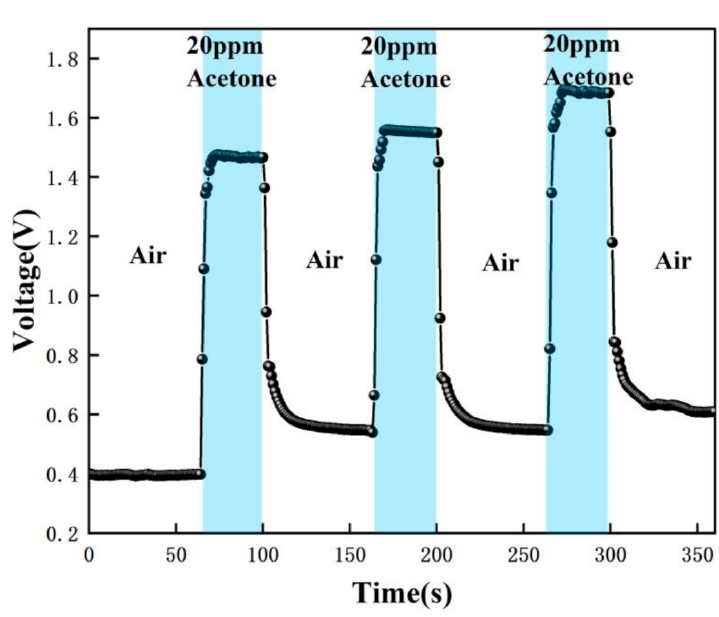
Figure 17. Test result of 20 ppm acetone.